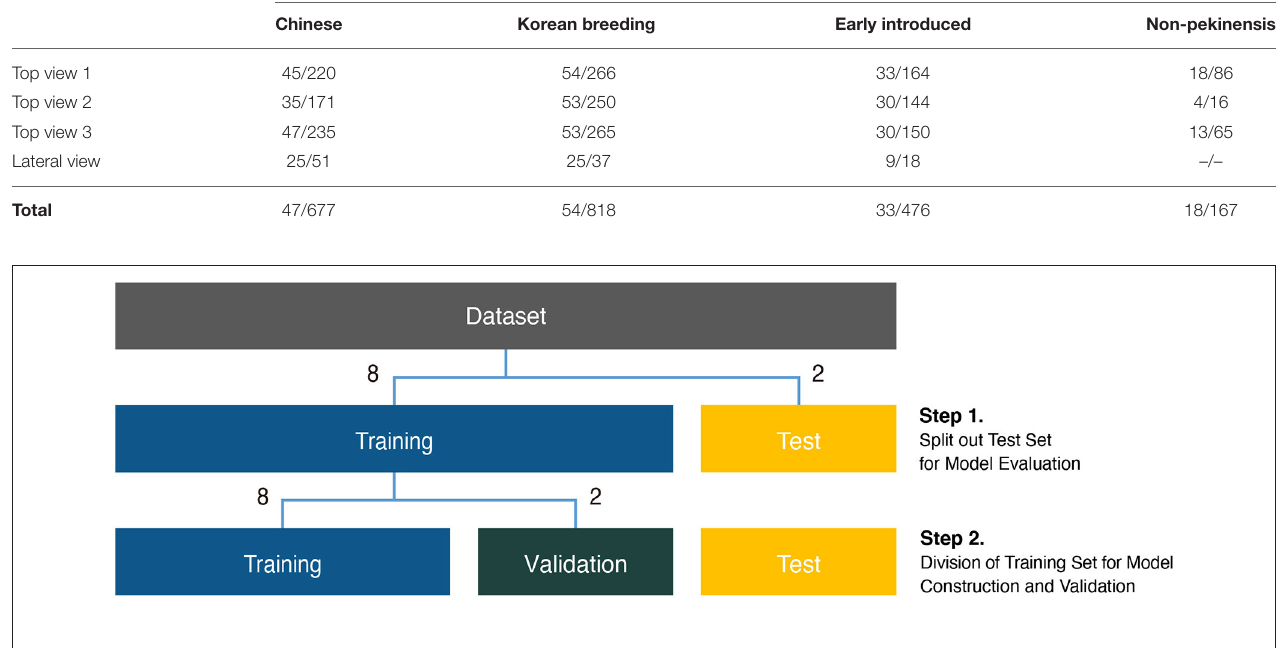
FIGURE 2 | Analysis scheme for phenotypic classification. Each dataset was divided into training, validation, and test sets for construction of classification models. The size ratio of the training and test sets was 8:2 for the model evaluation (Step 1). The training set was subdivided at an 8:2 size ratio for the model construction and validation (Step